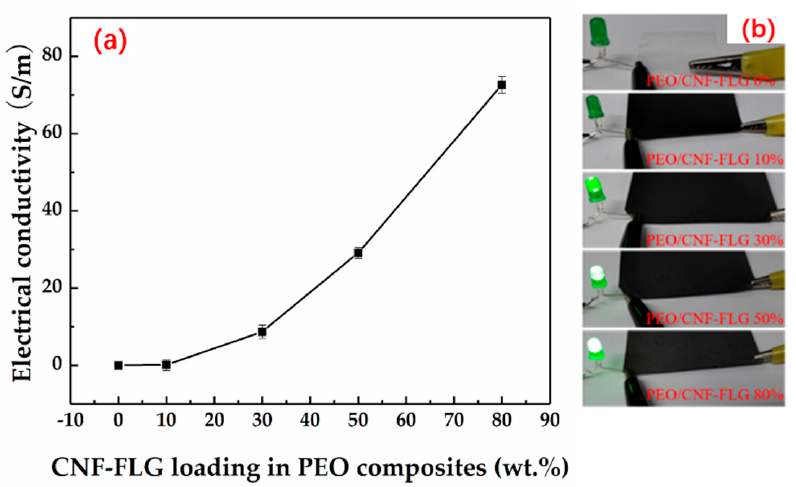
Figure 7. ( a ) Electrical conductivity of various PEO/CNFs-FLG composite films; ( b ) Lighting experiment with green LED.